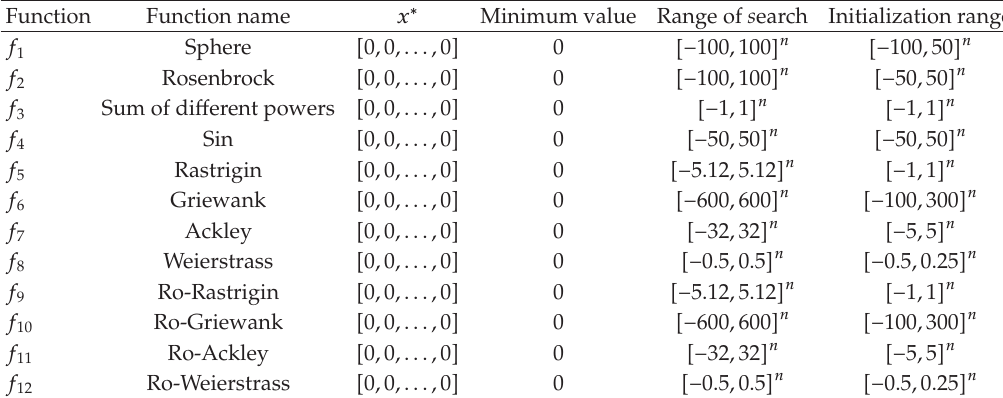
Pseudocode 4: Pseudocode of bacterial colony optimization. Table 1: Globe optimum, search ranges, and initialization ranges of test